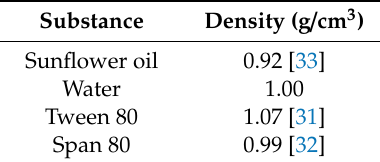
Table 3. Density values.